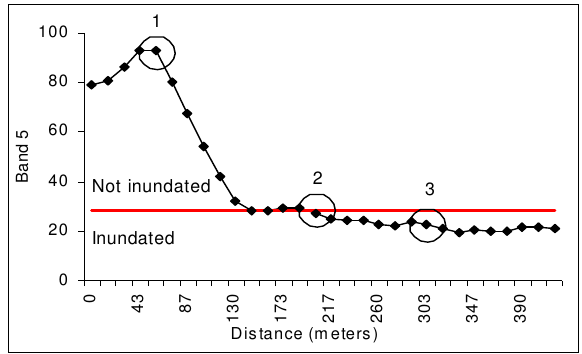
Figure 4: Band 5 values extracted along a transect line which includes 3 sample points with the derived threshold value in red.